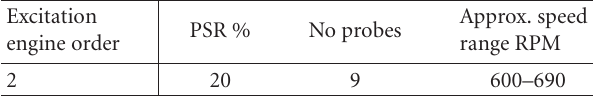
Table 2: Single resonance experimental test